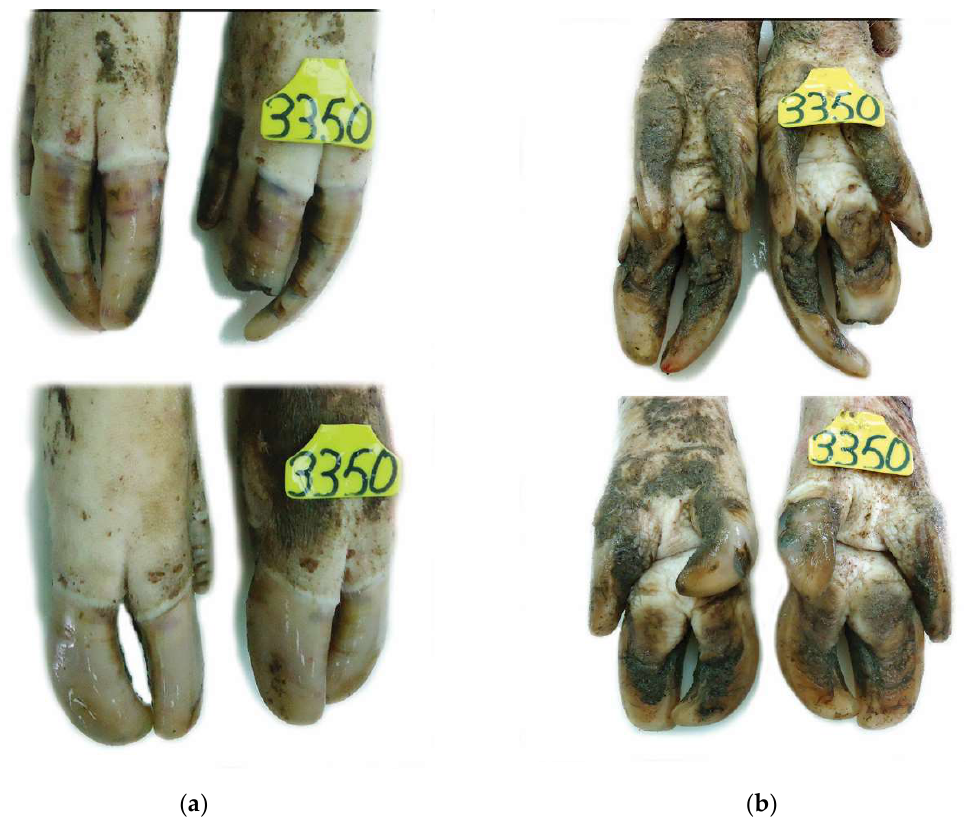
Figure 2. Claw lesions from a culled sow of genetic line B (Danbred): ( a ) Dorsal view: Grossly normal front limbs claws (bottom) with an intact wall and no deformity of the claw. Mildly overgrown claws of the hind limbs (top) showing superficial erosions, bruises and a ruptured hoof wall with exposure of phalange; ( b ) Ventral view: Extensive cavitation of the sole in both front and hind limbs.